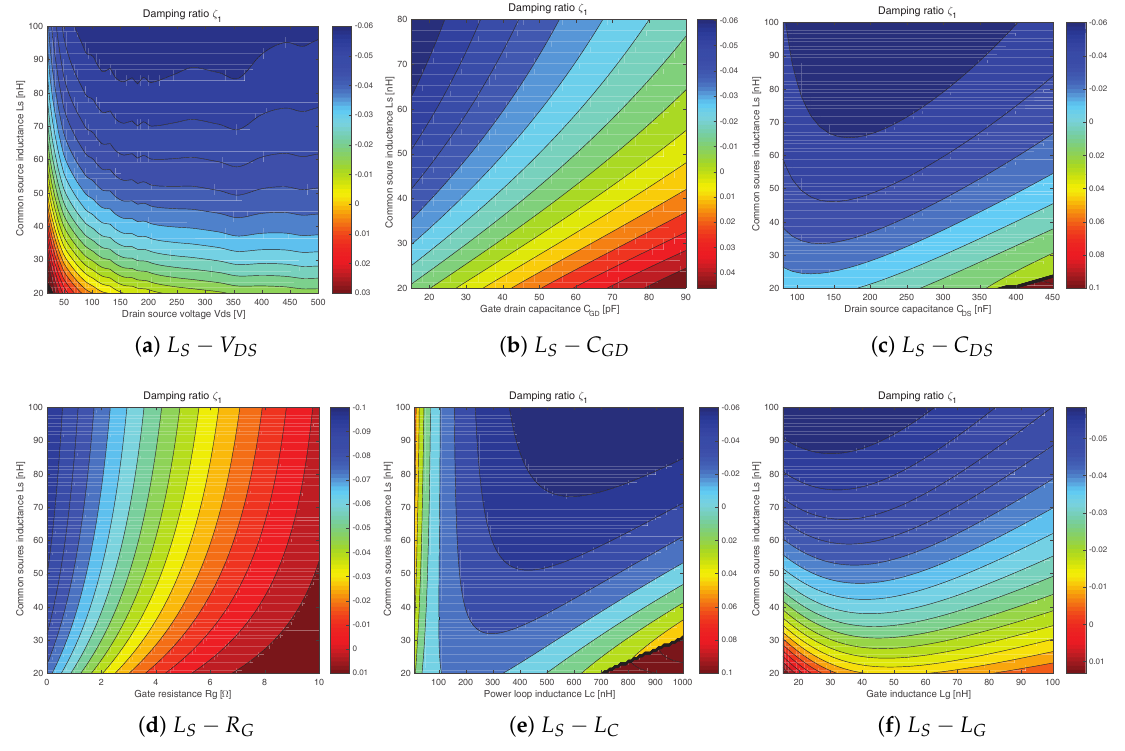
Figure 13. The calculated damping ratio ζ 1